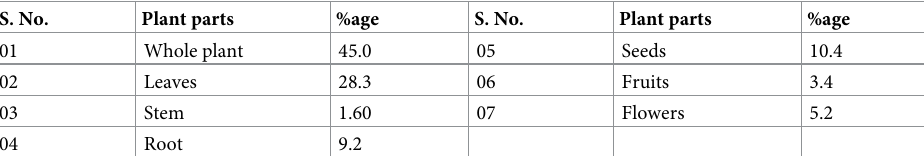
Table 5. %age of plant parts used to treat different diseases of SMR of District Bhimber of AJK,